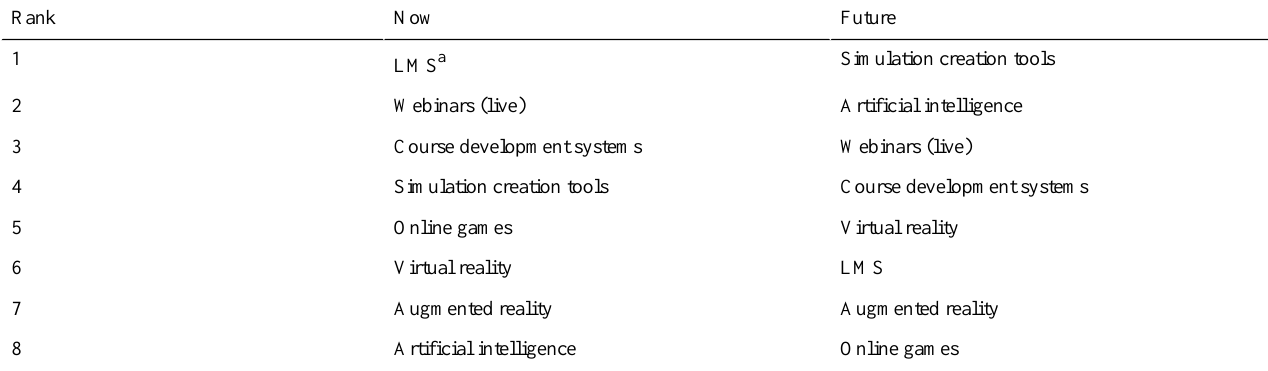
Table 5. Comparison between tools perceived to be most important now and in 5